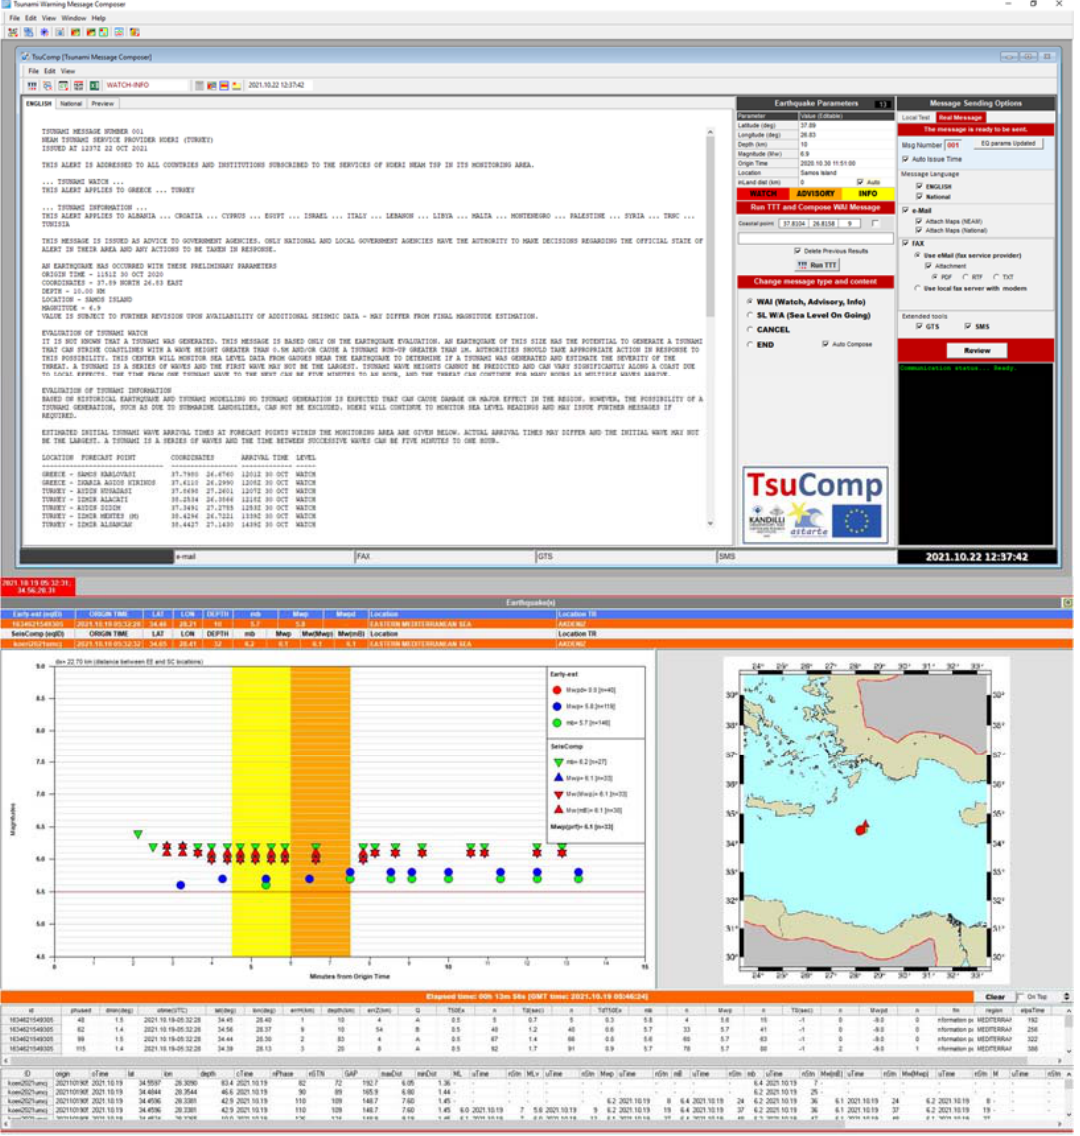
Figure 5. Main interface of TsuComp ( top ) and one of its sub–windows showing the various types of earthquake magnitudes calculated in real–time through automatic systems SeisComP3 and Early-est ( bottom ), where the duty officer is able to initiate the generation of the tsunami alert message by just clicking on the respective earthquake magnitude symbol.